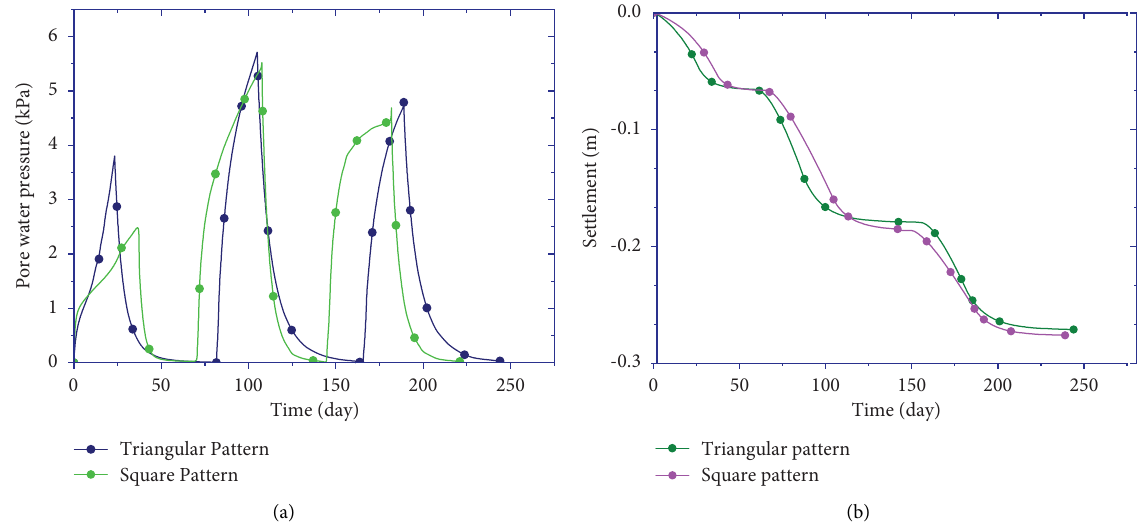
Figure 12: (a) Te efect of the installation pattern of SVD on pore water pressure (for diameter � 0.4m, S � 2.5m, and L � 8 m). (b) Te efect of the installation pattern of SVD on settlement (for D � 0.4m, S � 2.5 m, and L � 8